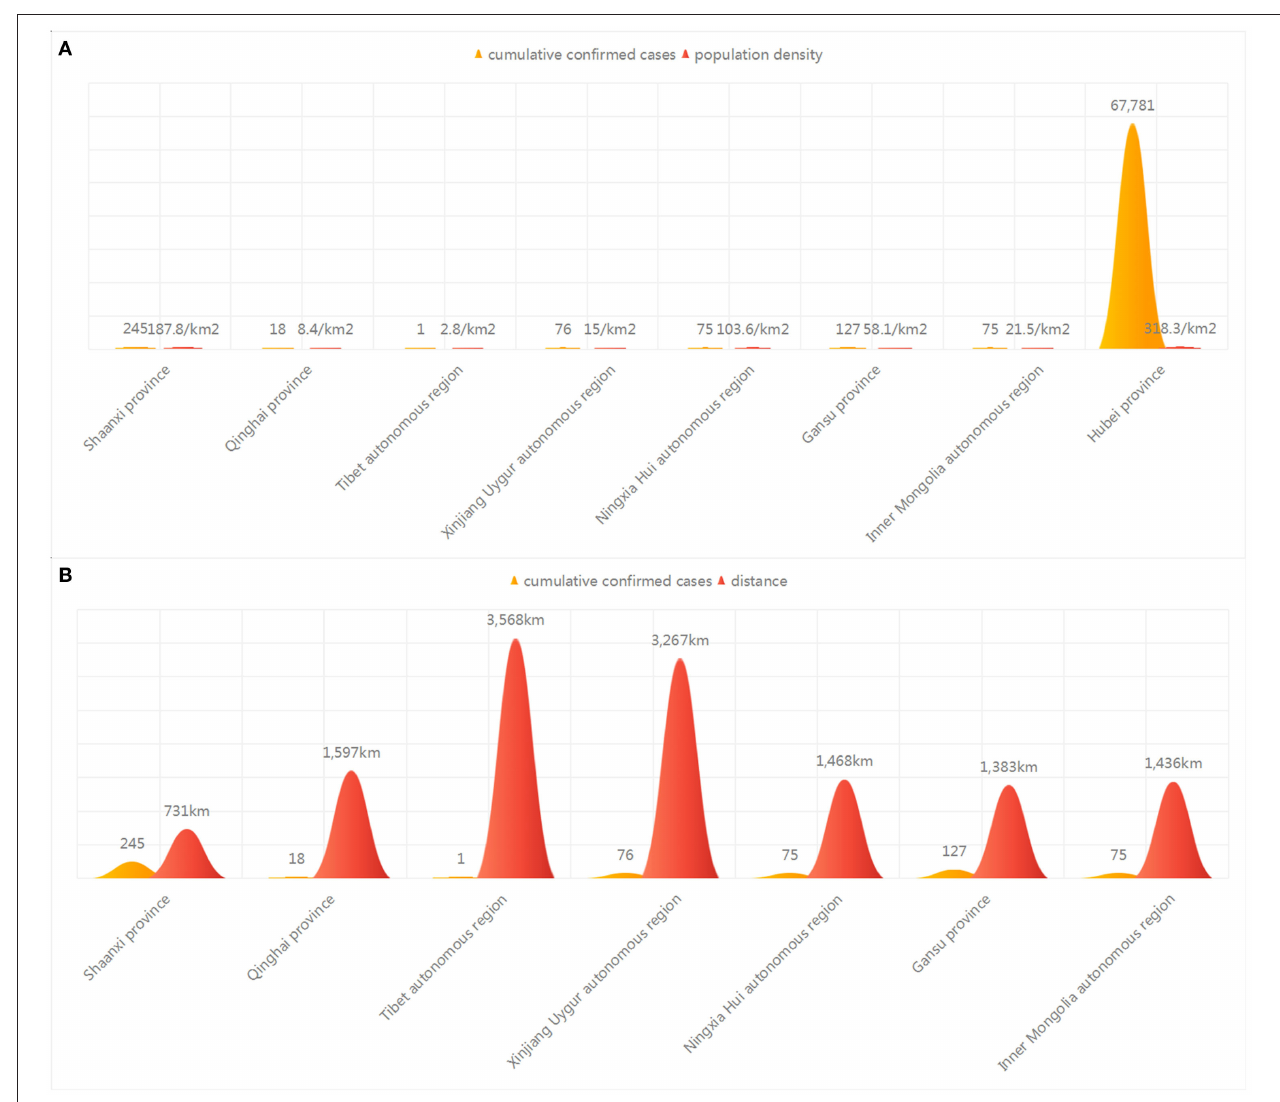
FIGURE 2 | Correlation between geographical factors and COVID-19. (A) Distribution of cumulative confirmed cases and population density in Northwestern China. (B) Distribution of cumulative confirmed cases and distances between the provincial capital and Wuhan City and Northwestern